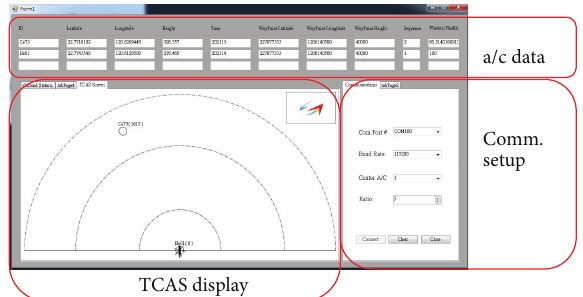
Figure 5: UAV/CD&R interface